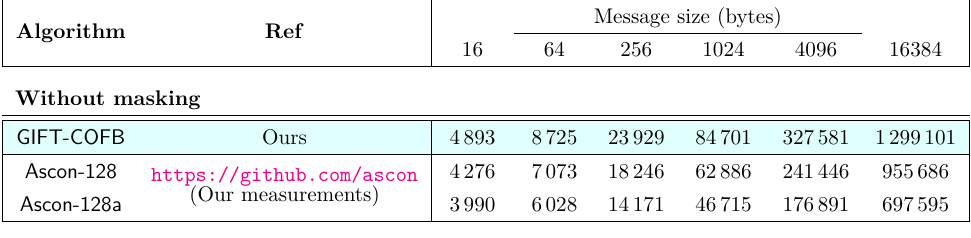
Table 7: Running time (cycles) of constant-time speed-oriented implementations of GIFT- COFB and Ascon on ARM Cortex-M4 for different message sizes along with 16 bytes of additional